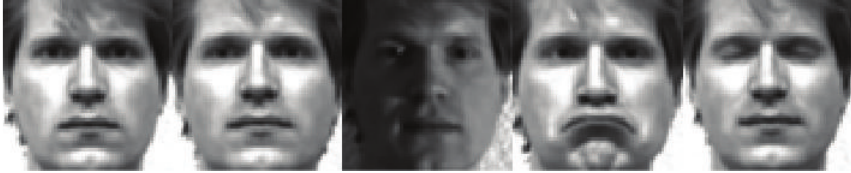
Figure 6: Some test samples from the Yale face database from the same